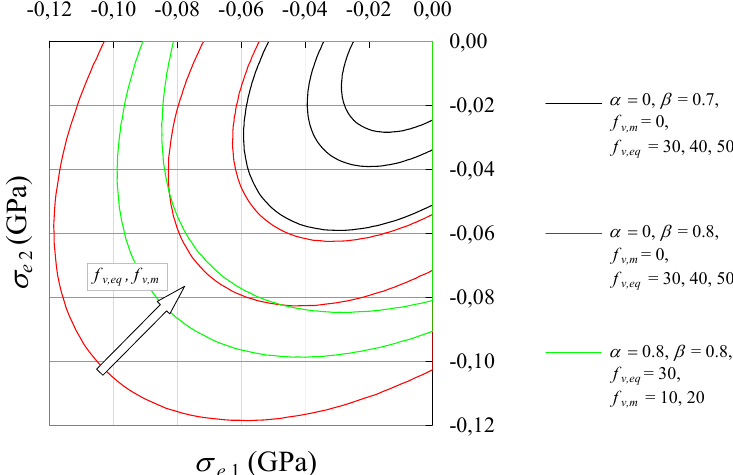
Figure 3: Failure curves in bi-axial compression.